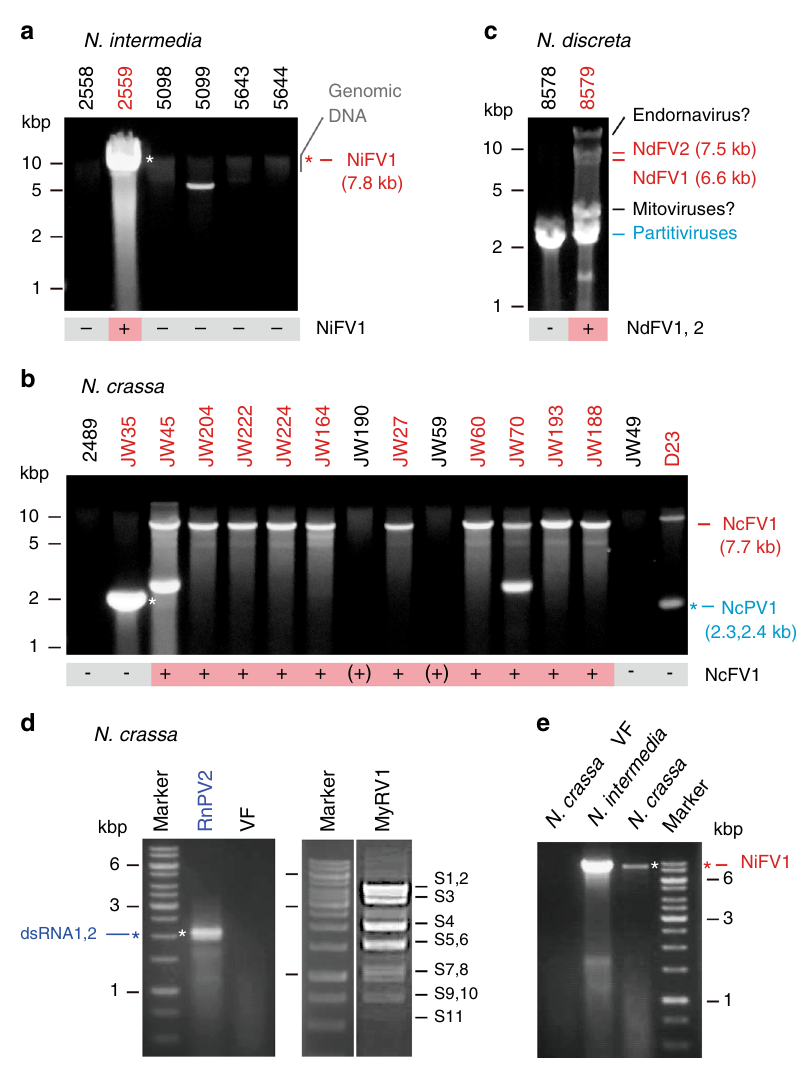
Fig. 1 Virus detection in Neurospora spp. and experimental introduction of heterologous viruses into the Neurospora crassa strain. Agarose gel electrophoresis of dsRNA fractions obtained from N. intermedia ( a ), N. crassa ( b ), and N. discreta ( c ). After electrophoresis, dsRNA extracted from isolates of Neurospora spp. shown on the top of each gel was stained with GelGreen (Biotium, Inc.). Fully sequenced viruses are Neurospora intermedia fusarivurs 1 (NiFV1), Neurospora crassa fusarivurs 1 (NcFV1), and Neurospora crassa partitivirus 1 (NcPV1). Multiple dsRNA bands were detected in N. discreta isolate FGSC #8549 that is expected to represent the genomes of several RNA viruses (Table 1). The 15 fi eld-collected N. crassa strains were subjected to dsRNA analyses together with a potential virus-free standard strain FGSC #2489 (Supplementary Table 1). The discrete dsRNAs of ~2 – 3 kbp detectable in N. crassa JW45, JW70, and D23 may be defective RNAs. d Experimental introduction of encapsidated dsRNA viruses into N. crassa via virion transfection. Virions of Rosellinia necatrix partitivirus 2 (RnPV2) and mycoreovirus 1 (MyRV1) were puri fi ed from their original host fungi and transfected into protoplasts of the standard strain of N. crassa . DsRNA was isolated from the representative transfectant by RnPV2 and MyRV1 as well as the virus-free standard strain (VF) and electrophoresed in agarose gel. Lane M indicates 1-kb DNA ladder (Thermo Fisher Scienti fi c). e Experimental introduction of a putative capsidless ( + ) ssRNA virus into N. crassa . Protoplasts of N. intermedia (FGSC #2559) infected by a fusarivirus NiFV1 and the standard N. crassa strain were fused. Each of the experiments shown in panels a – e was independently repeated at least